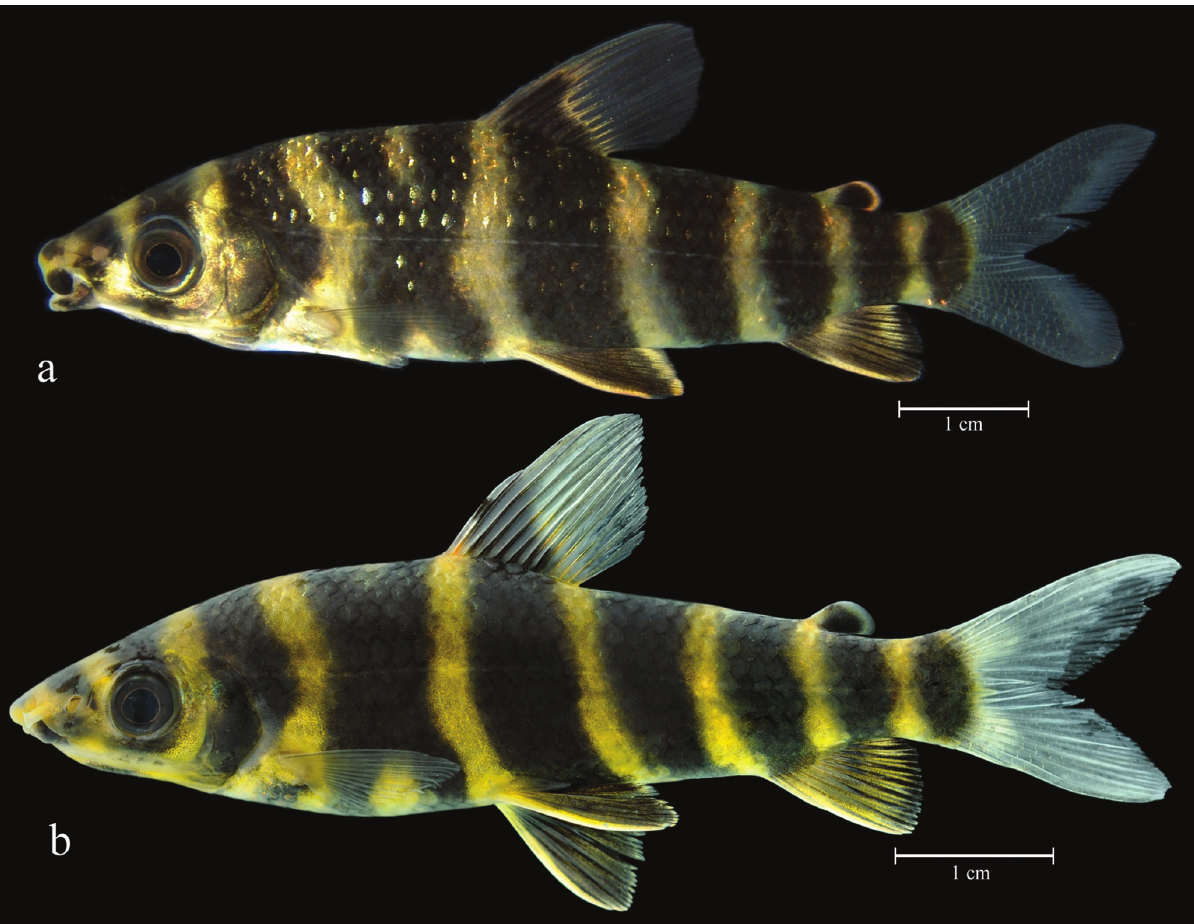
Fig. 6. Live specimens of Leporinus villasboasorum : (a) MZUSP 91895, 70.2 mm SL, paratype, rio Culuene, Xingu basin in Brazil, photographed by Leandro Sousa, (b) INPA 40080 , 56.0 mm SL, rio Xingu at Altamira, Brazil, photographed by Mark Sabaj.